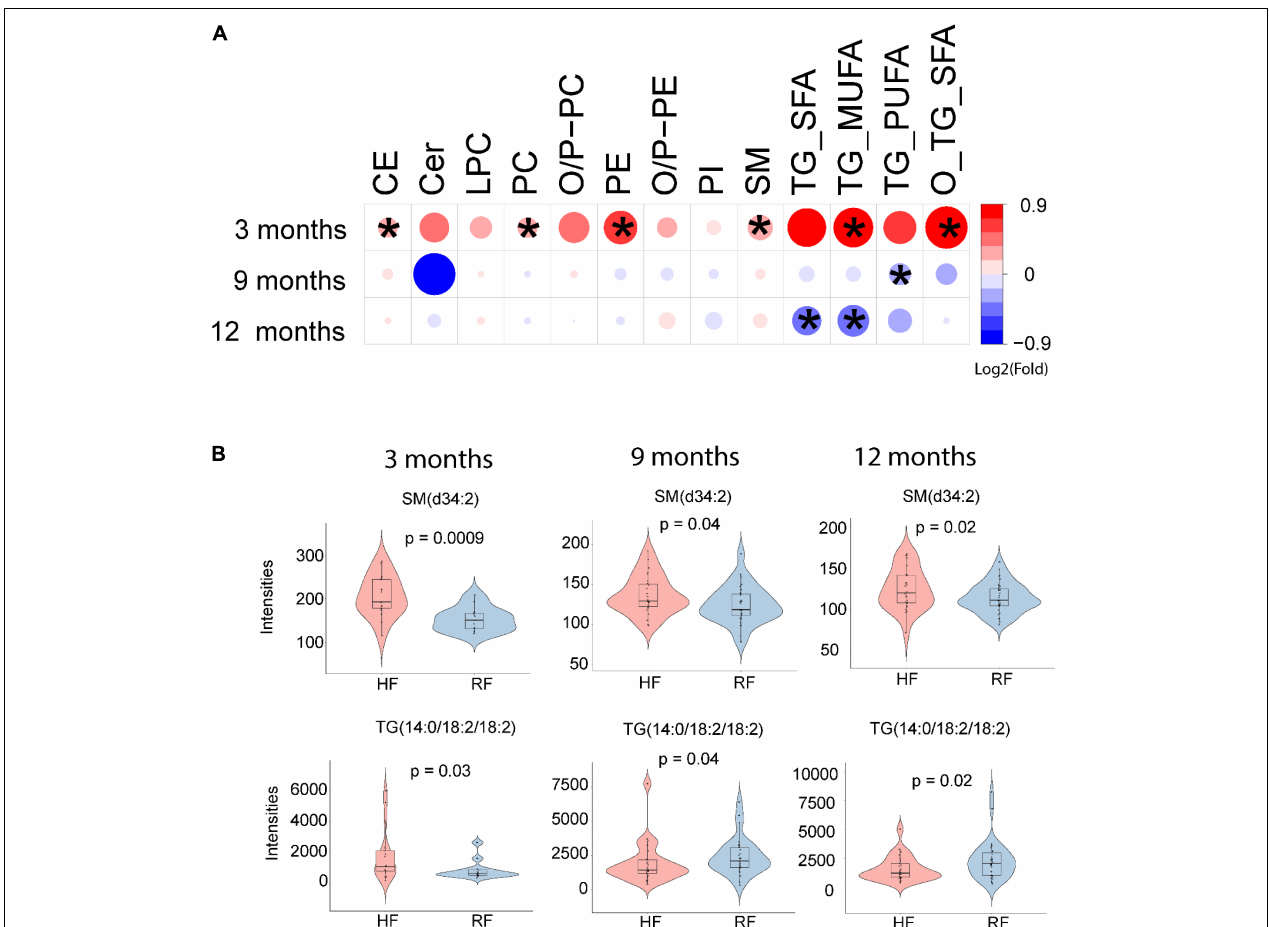
FIGURE 2 | Comparison of lipidome between the infants who consumed an extensively hydrolyzed milk formula vs. a conventional cow’s milk-based formula. (A) Total lipid concentration differences in each lipid class between the intervention groups. (B) Box plot showing selected lipid species representative of lipid classes that change at 3, 9, and 12 months of age when comparing the study groups. Here, HF stands for extensively hydrolyzed infant formula and RF for conventional regular infant